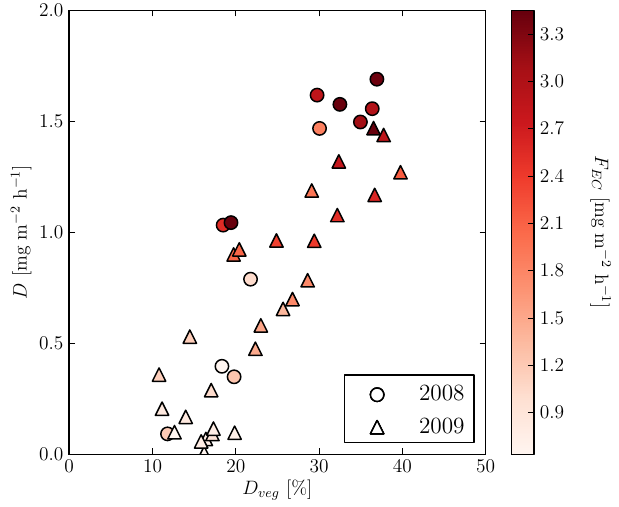
Figure 9. Difference between the calculated fluxes from the two methods ( D ) vs. “vegetation composition difference” ( D veg ). Colours from white to red show the magnitude of the EC